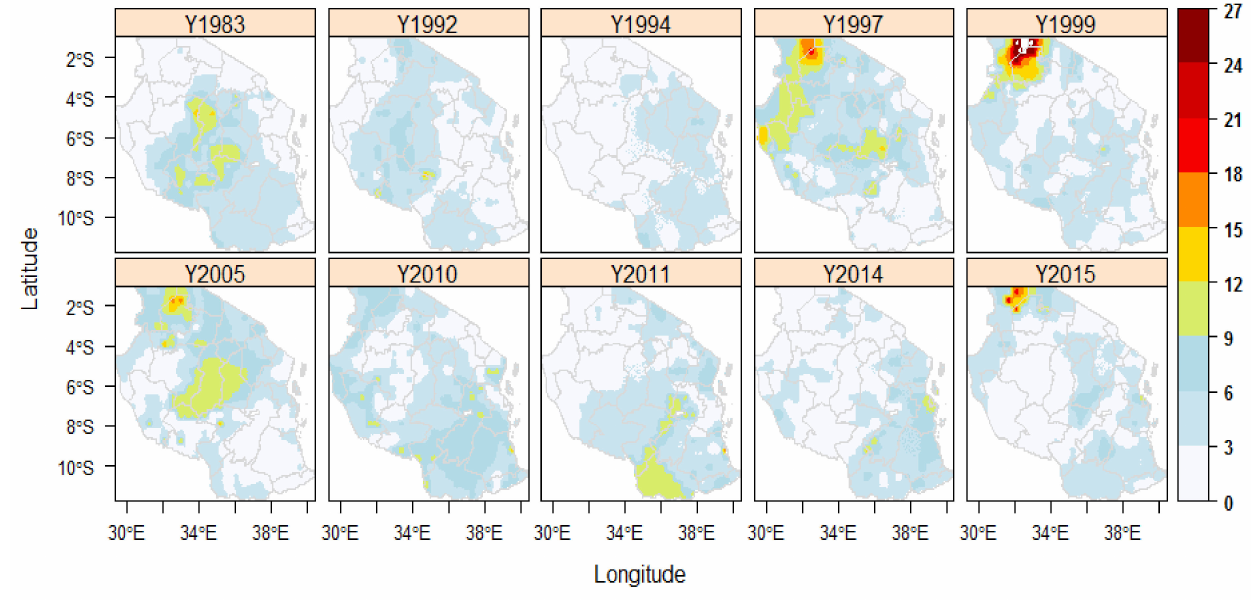
Figure 5. Duration of heatwave events of Figure